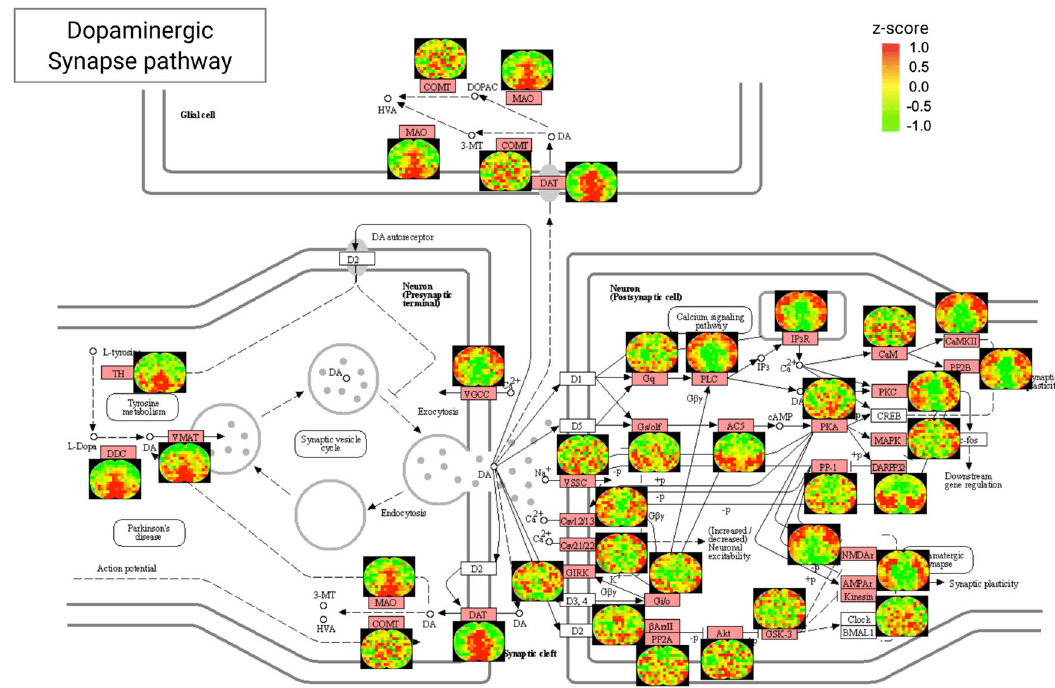
Fig. 5 | Cerebral distribution maps of key proteins involved in the KEGG pathway of the dopaminergic synapse acquired by MASP. The z-score color scale is from − 1.0 (green) to 1.0 (red). The red boxes on the KEGG pathway plots denote the proteins quanti fi ed by